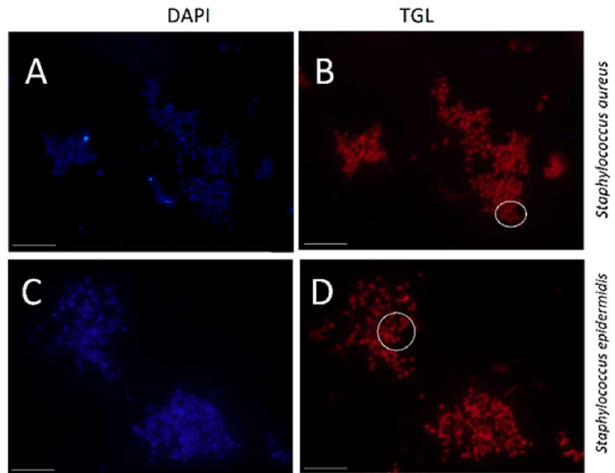
Figure 7. Images of both S. aureus ( A , B ) and S. epidermidis ( C , D ) stained with the EUB338–BHHTEGST–Eu 3 + probe are shown. ( A , C ) DAPI nuclear staining; ( B , D ) time-gated luminescence (TGL) staining are shown. Oil immersion 100× objective and TGL exposure times at 2.0 Sec. were used. The scale bar indicates 10 µm. ( B ) S. aureus is at S = 72.1, N = 5 and SNR = 14.4. ( D ) S. epidermidis is at S = 81, N = 5 and SNR = 16.2.